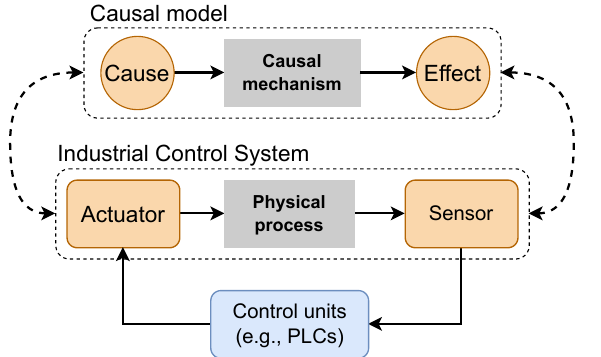
Figure 1. Analogy between the main components of a typical ICS and a causality-based